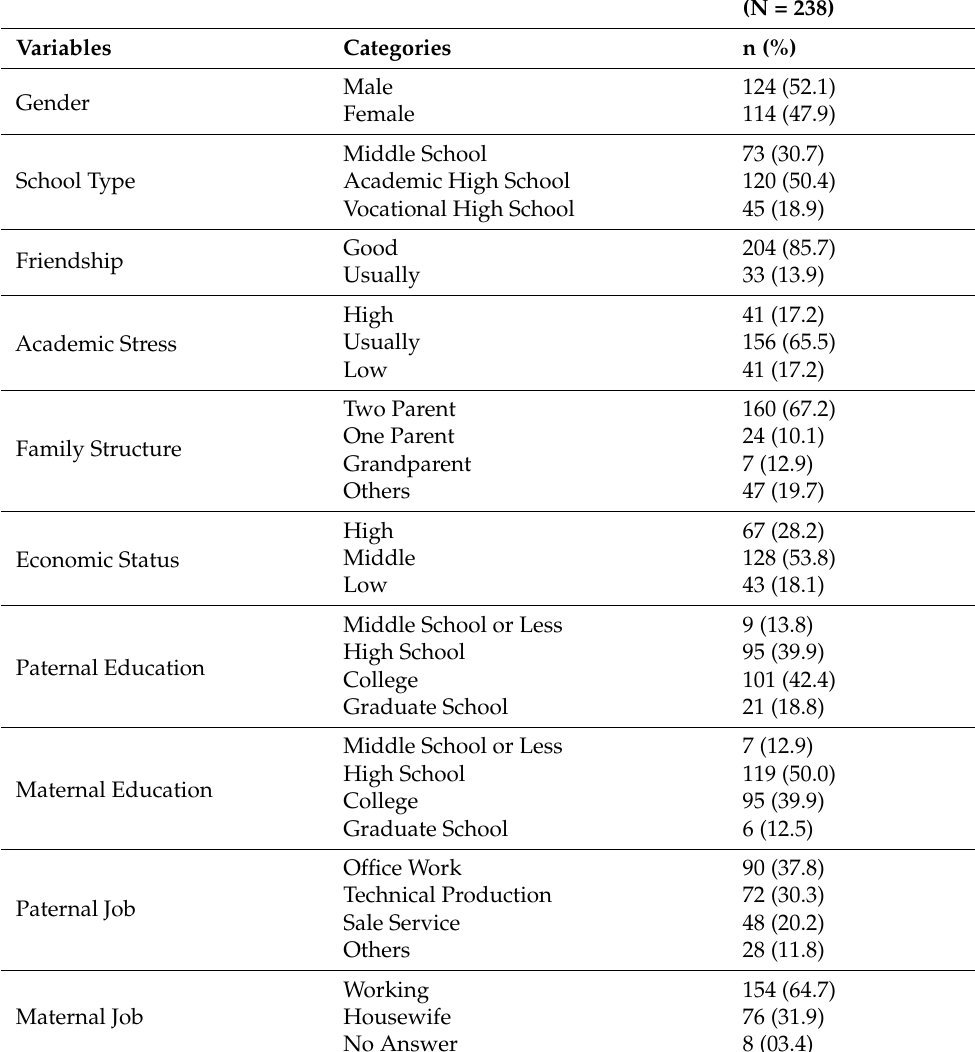
Table 1. Participants’